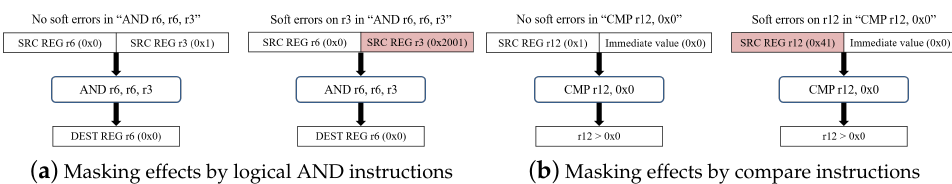
Figure 4. Software-level masking effects analysis from logical and compare instructions.